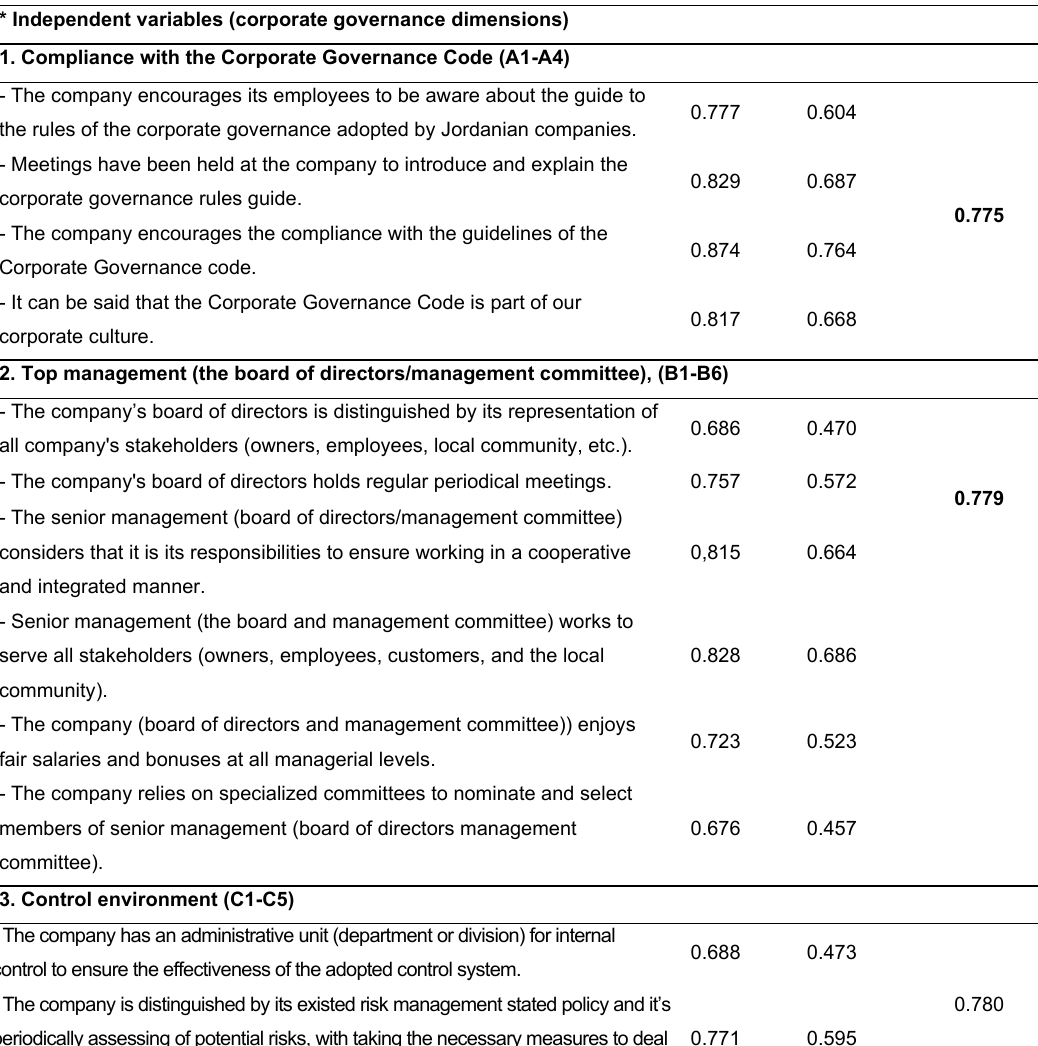
Table 6. Factor analysis and KMO of